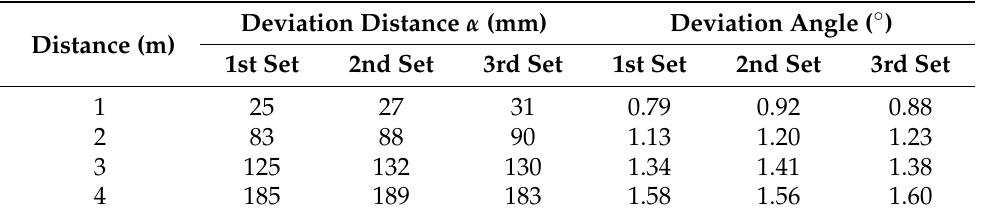
Table 3. Results of straight line motion experiment in tracked mode.